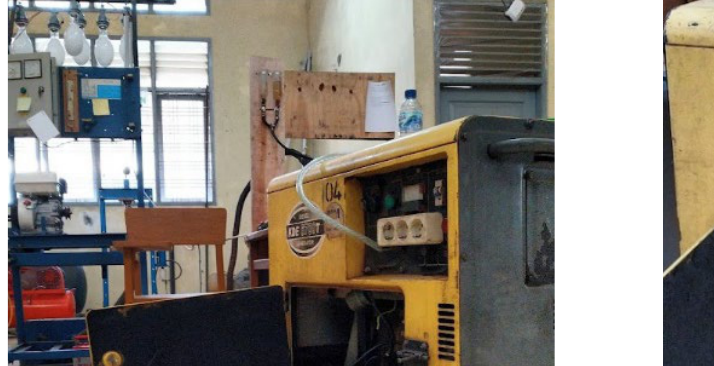
Figure 4. Experimental test apparatus: ( a ) KDE 6700T power generator and test instruments ( b ) modified external fuel line system bypassing default fuel tank.